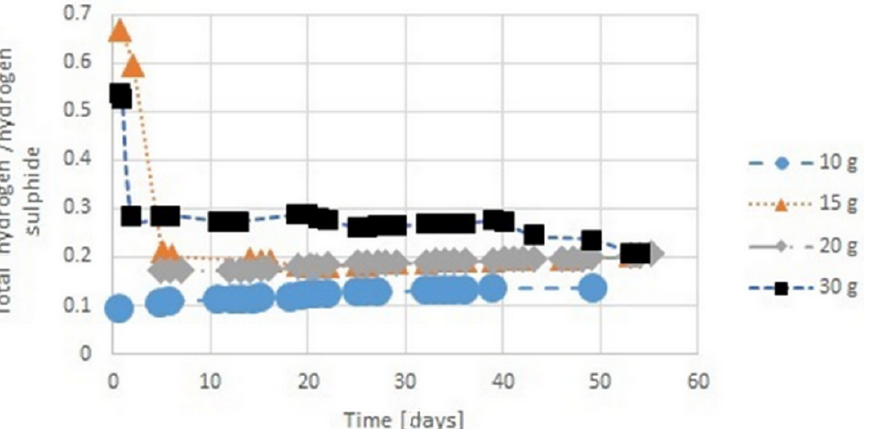
Figure 12. Ratio of total hydrogen to hydrogen sulphide ratio in all 55 days for gelatine concentration from 10 g VSS/L to 30 g VSS/L.